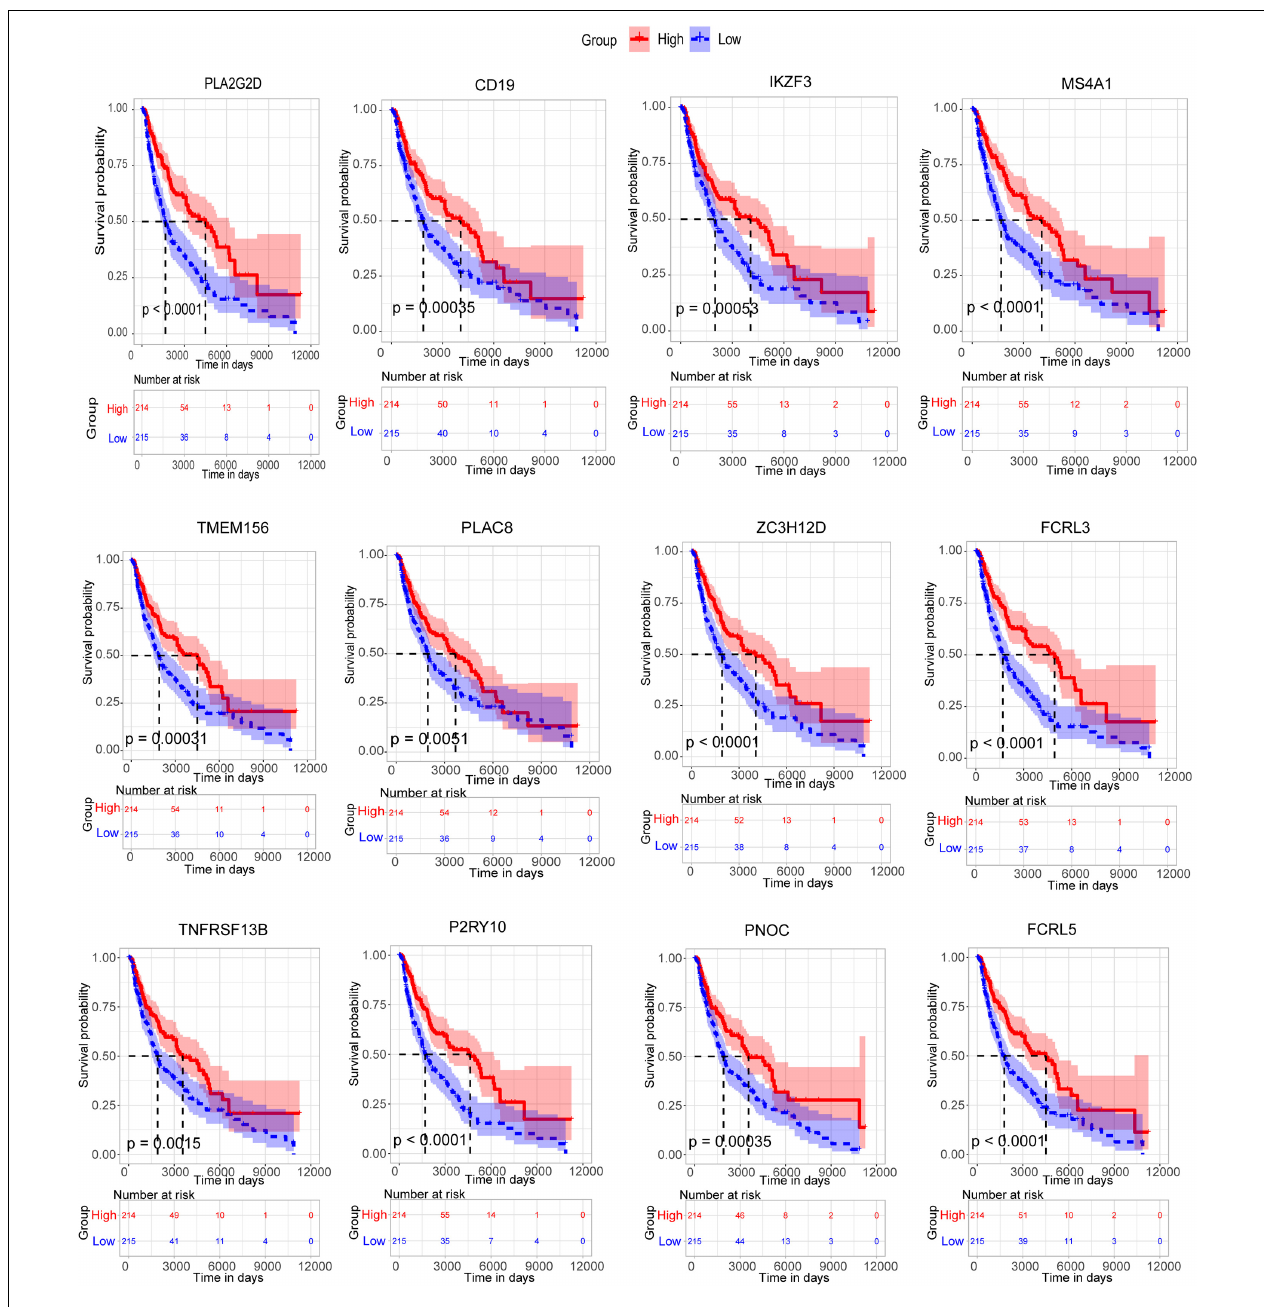
FIGURE 5 | Survival analysis of 12 candidate metastasis-associated key